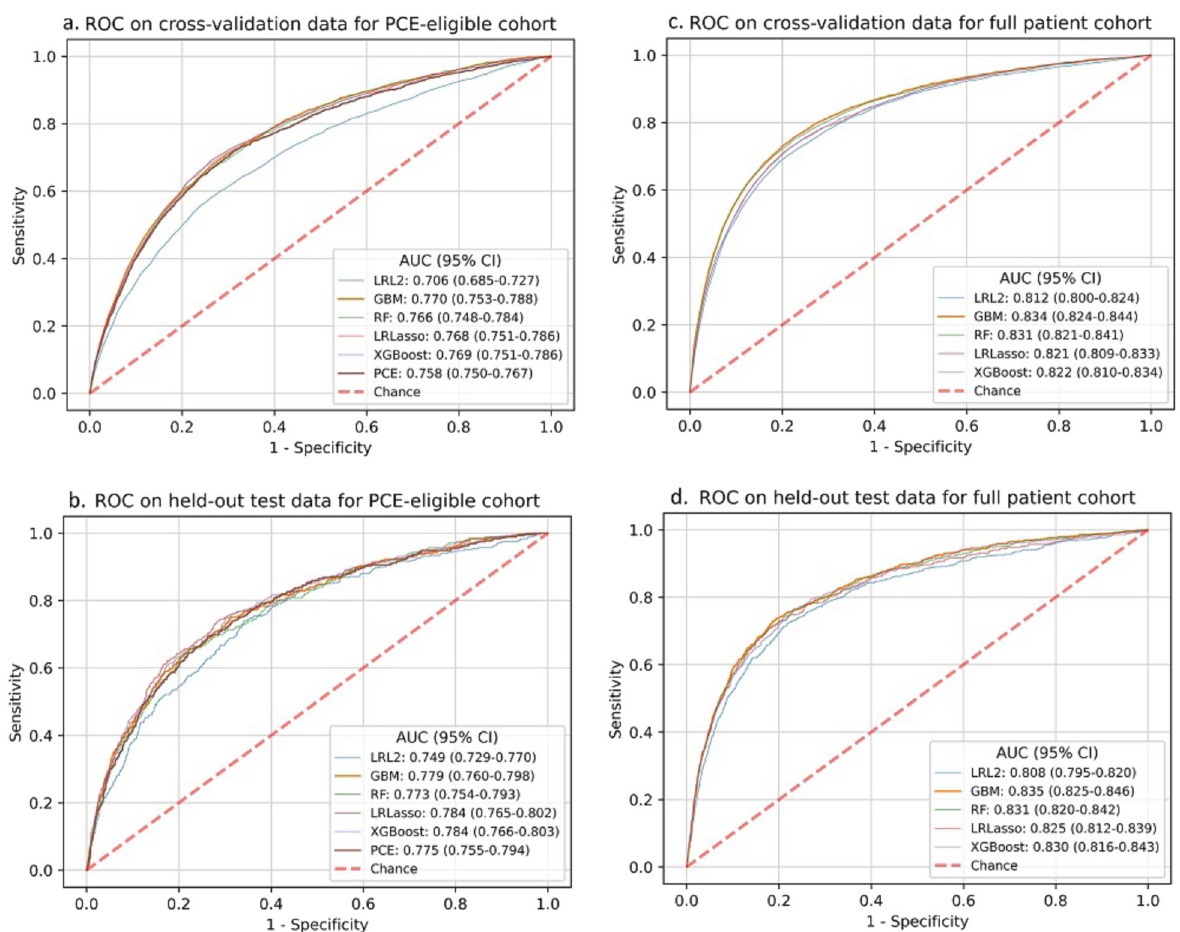
Fig. 2 ROC curves for PCE and ML model performance. ROC curves are outlined for PCE versus model ML performance in the PCE-eligible cohort (in a cross-validation and b held-out test data) and ML model performance on the full cohort (in c cross-validation and d held-out test data). Legend entries denote the AUC for each method with 95% con fi dence intervals. ROC receiver-operating characteristic, PCE pooled cohort equations, ML machine learning, AUC area under receiver-operating characteristic curve, LRL2 logistic regression with an L 2